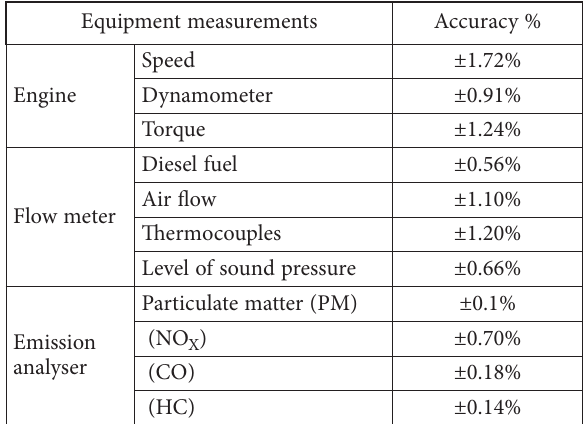
Table 2. Accuracy of the experimental measurements of the